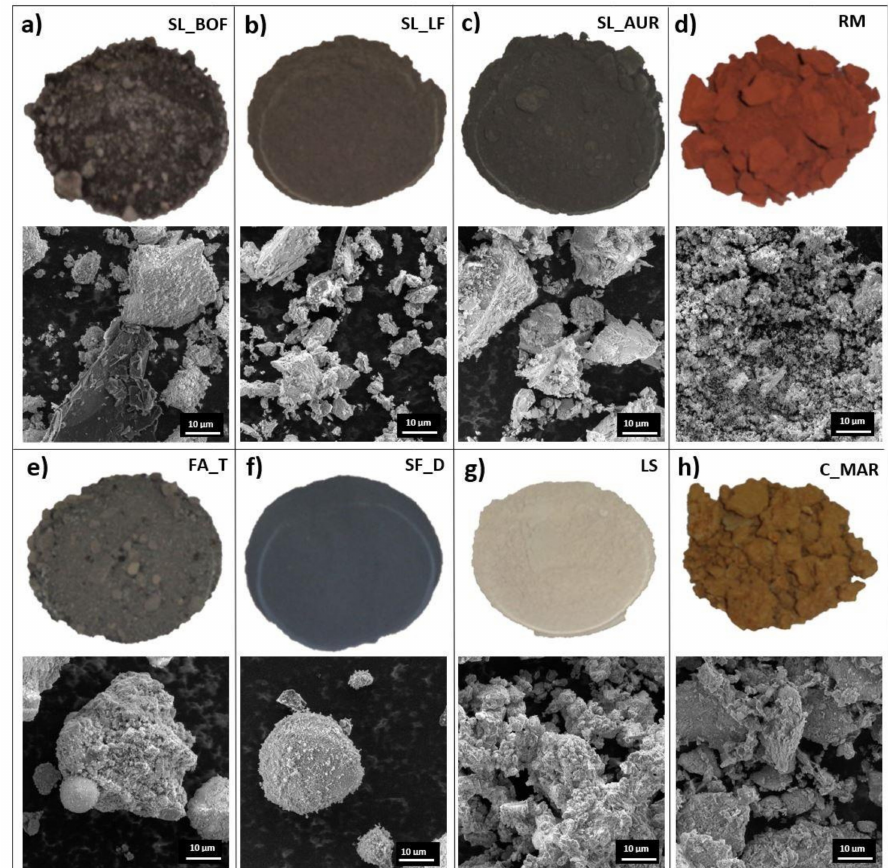
Figure 3. Visual appearance of as-collected materials from di ff erent industries ( top image ) and their particle appearance obtained with SEM ( bottom image ) used for morphological